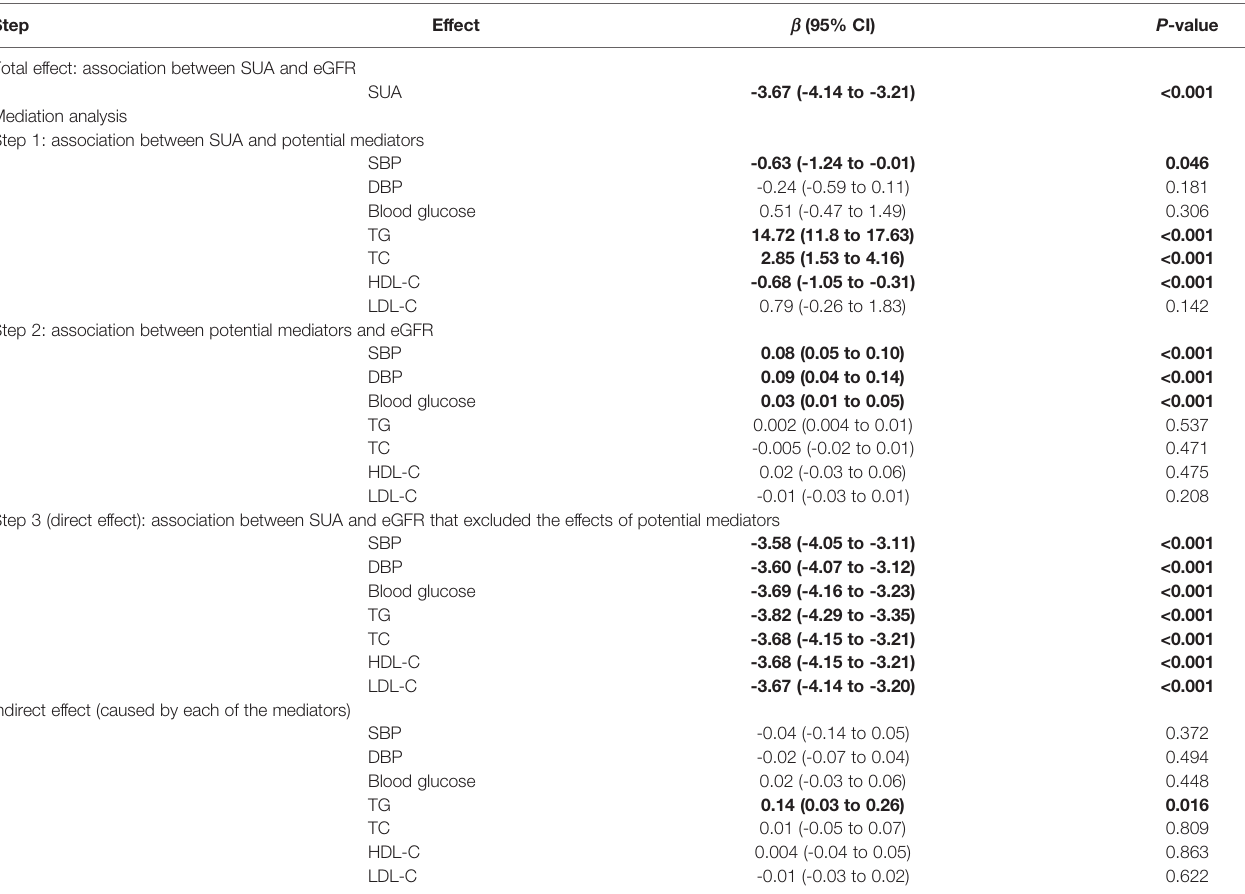
TABLE 4 | The mediating effects of cardiometabolic factors on the association between SUA and eGFR in